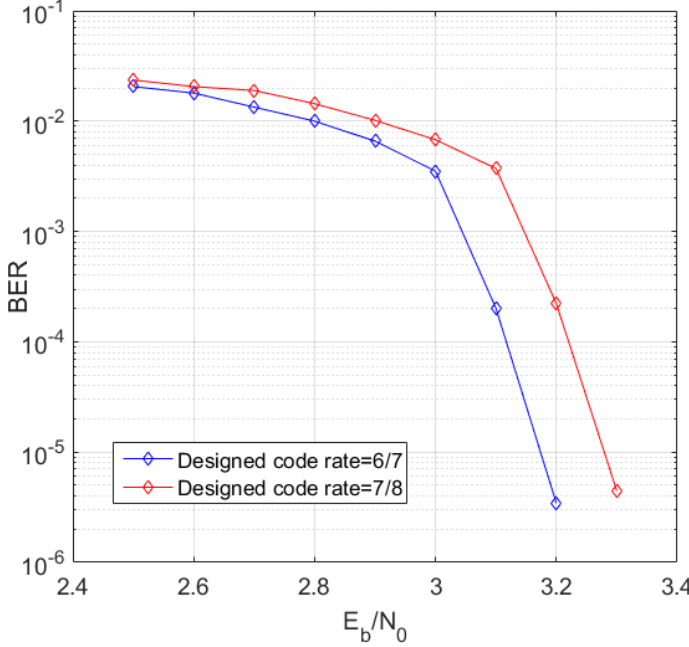
Figure 16. Designed 7/8 rate code